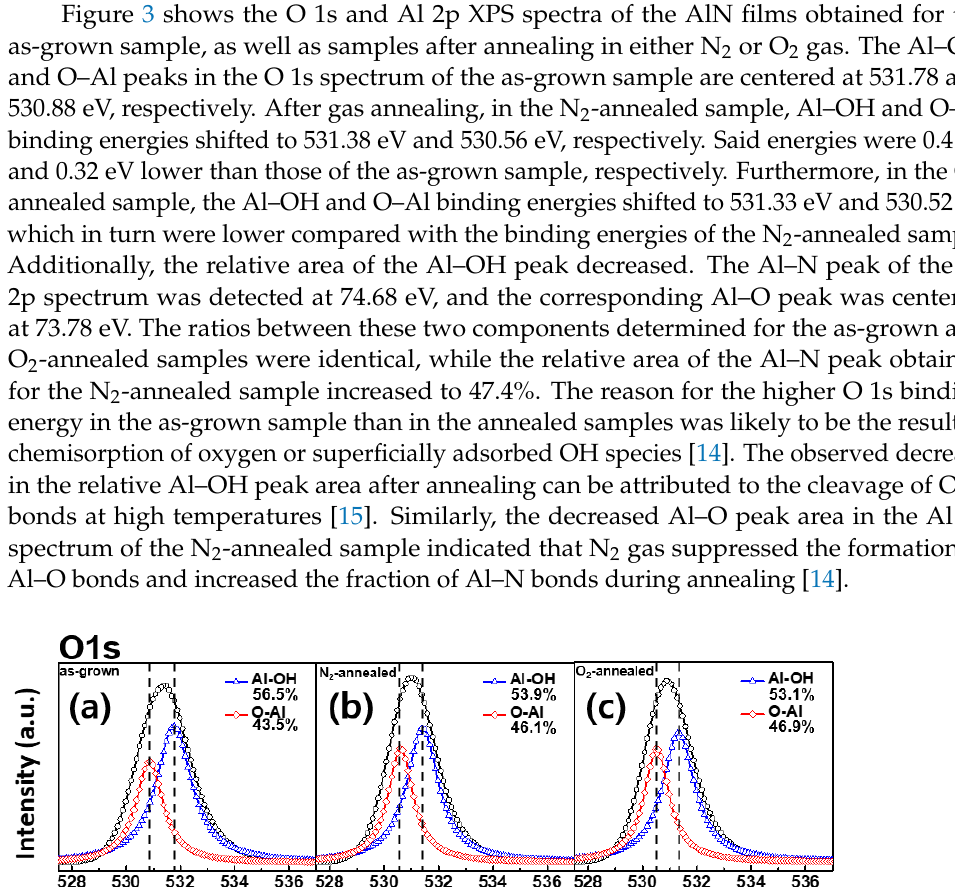
Figure 2. AlN film morphology SEM imaging ( a ) as-grown, ( b ) N 2 -annealed, and ( c ) O 2 -annealed samples.